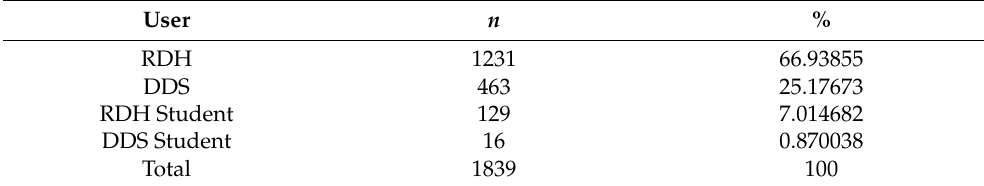
the application; RDH = registered dental hygienist; DDS = doctor of dental surgery.